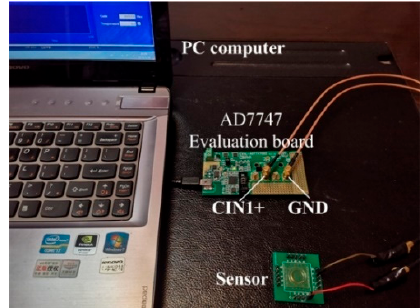
Table 4. Initial capacitance of five capacitors.